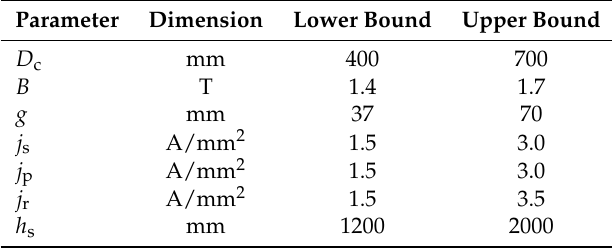
Table 4. The applied bounds for the independent